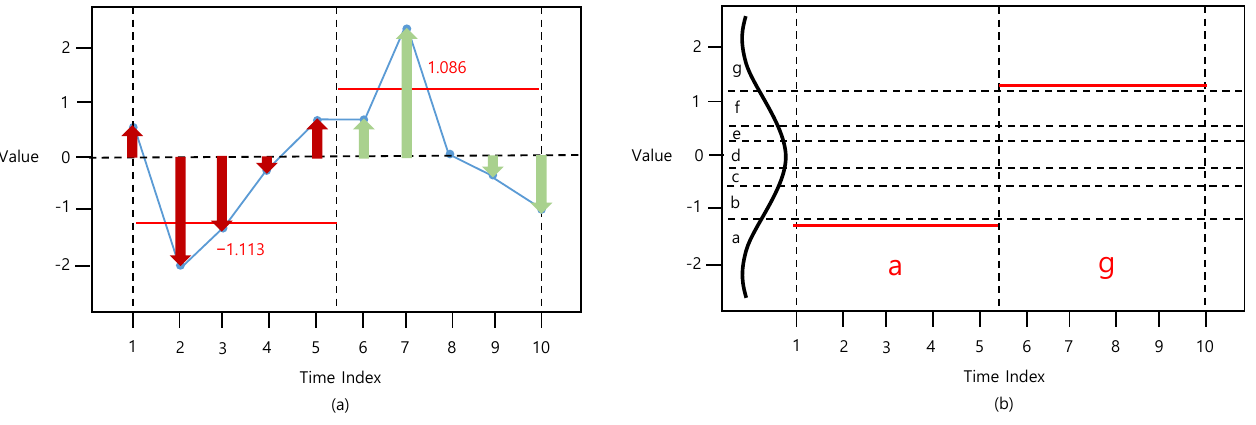
(cid:104) (cid:105) x D − PAA , . . . , x D − PAA S 1 (cid:104) (cid:105) x D − SAX , . . . , x D − SAX . In this phase, the S 1